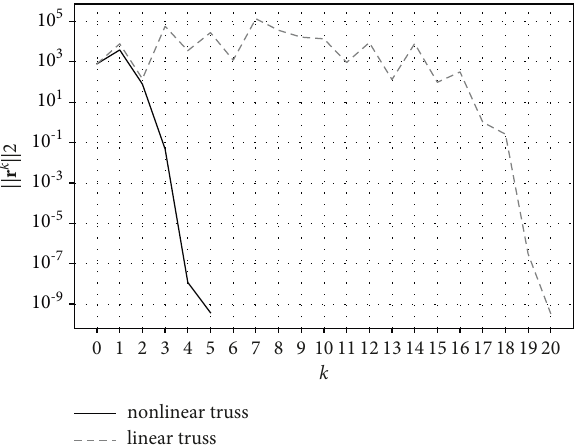
Figure 18: Convergence of the 3D bridge